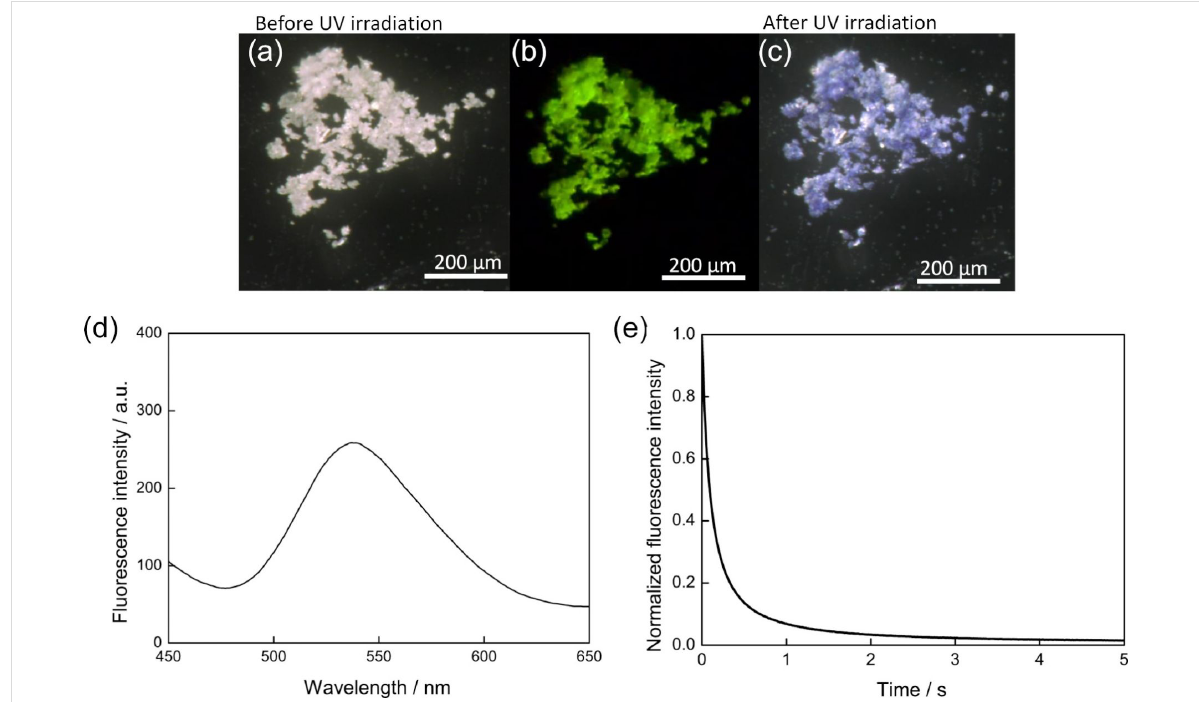
Figure 7: (a) Crystals of 1o before UV light irradiation, (b) Green fluorescence of 1o observed under UV light ( λ = 365 nm) irradiation, (c) Cyclization proceeded to form 1c with suppression of the fluorescence, (d) Fluorescence spectra of 1o in the crystalline state ( λ ex = 370 nm, λ max = 537 nm), (e) The fluorescence quenching of 1o in the crystalline state ( λ ex = 370 nm, λ em = 537 nm) upon UV